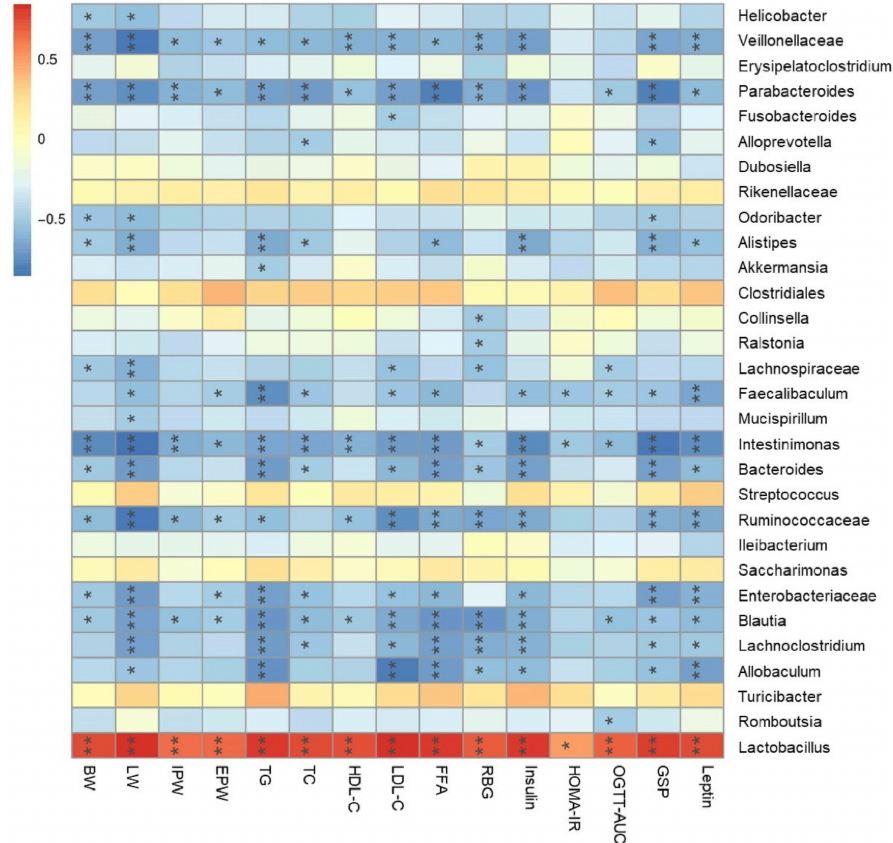
Figure 10. Heatmap of correlation between microbiota and metabolic syndrome parameters. BW, body weight; LW, liver weight; IPW, inguinal pad weight; EPW, epididymal pad weight; RBG, random blood glucose. Significant correlations are denoted as * p < 0.05, ** p <